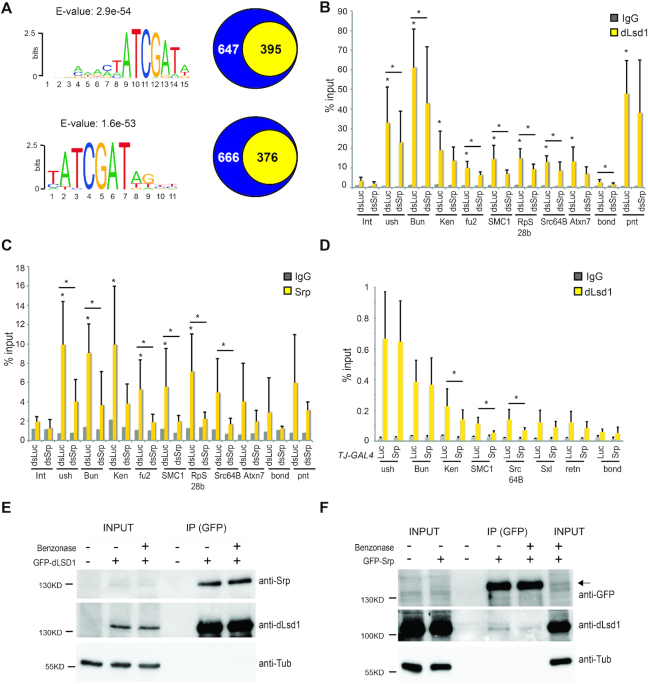
The GATA factor binding motif is enriched at dLsd1 ChIP-Seq peaks. (A) dLSD1 peaks MEME analysis. Shown are the sequence logos of the top 2 motifs found by performing an analysis of the sequences of dLsd1 peaks proximal to TSS using the MEME suite program. The E-values corresponding to each motif are indicated. The numbers in the yellow and blue circles of the Venn diagrams indicate respectively how many dLsd1 peaks carry or not the motifs shown. (B) Serpent depletion affects dLsd1 binding at a subset of GATA motif carrying genes in S2 cells. ChIP-qPCR analysis of dLsd1 binding at a subset of dLsd1 targets carrying a putative GATA motif in S2 cells treated with either dsRNA against luciferase (control) or against srp. A Wilcoxon test was performed to indicate significance (*P < 0.05). (C) Srp binds a subset of dLsd1 target genes. ChIP-qPCR analysis of Srp binding at a subset of dLsd1 targets carrying a putative GATA motif in S2 cells. IgG were used as a control for specificity. Int is an intergenic region used as negative control, ush is a previously identified Serpent target used as a positive control, pnt is a dLsd1 target that does not carry a GATA motif and bond is a gene which is not supposed to be bound by neither Srp nor dLsd1. All ChIP experiments were performed at least in triplicate, and error bars indicate standard errors of the means. A Wilcoxon test was performed to indicate significance (*P < 0.05). (D) Serpent depletion affects dLsd1 binding at a subset of GATA motif carrying genes in ovaries. ChIP-qPCR analysis of dLsd1 binding at a subset of dLsd1 targets carrying a putative GATA motif in ovaries expressing an RNAi against luciferase or srp under the control of the Traffic Jam GAL4 (TJGAL4) driver. Retn is a dLsd1 target that does not carry a GATA motif. A Wilcoxon test was performed to indicate significance (*P < 0.05). (E) dLsd1 and Srp physically interact. Immunoblot showing co-immunoprecipitation of endogenous Srp with GFP-tagged dLsd1 in S2 cells. The immunoprecipitated GFP-dLsd1 is also shown and Tubulin was used as negative control. Benzonase was added where indicated. (F) Immunoblot showing co-immunoprecipitation of endogenous dLsd1 with GFP-tagged Srp in S2 cells. GFP-Srp is also shown (indicated by an arrow). Tubulin was used as a negative control. Benzonase was added where indicated.